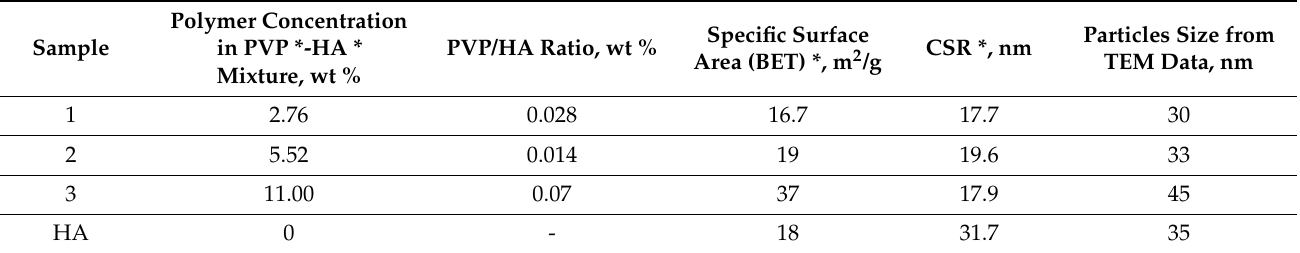
Table 2. Dimensional characteristics of powders obtained from the PVP-HA composites (samples 1–3, Table 1) after heat treatment at T = 400 ◦ C, determined by TEM, BET and XRD